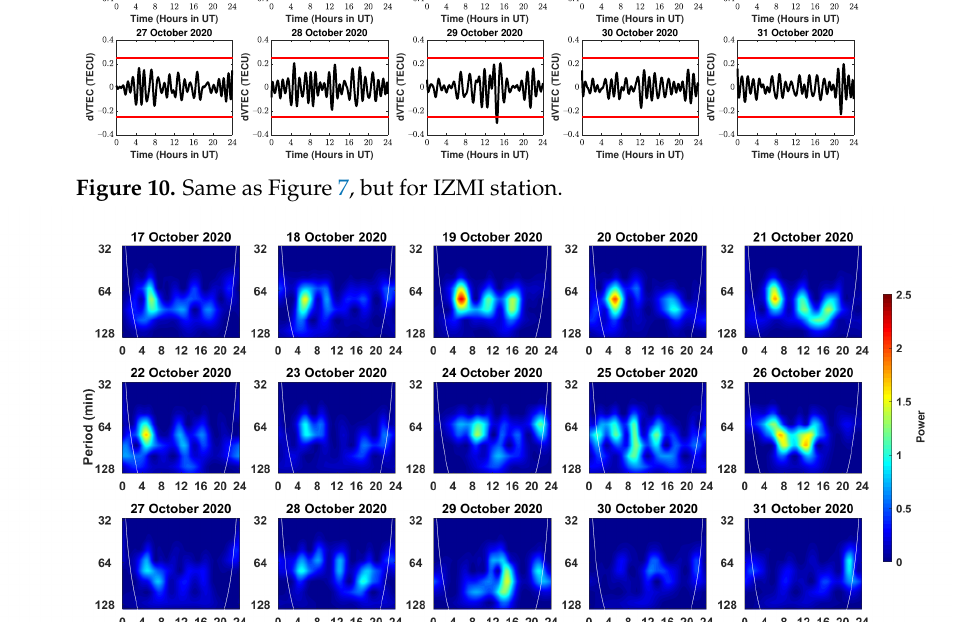
Figure 11. Same as Figure 8, but for IZMI